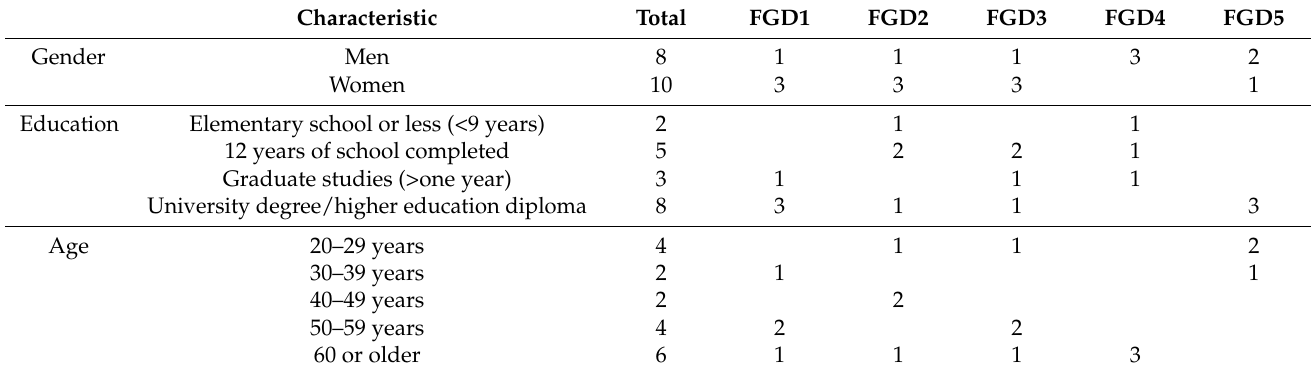
Table 2. Characteristics of study participants per focus group discussion